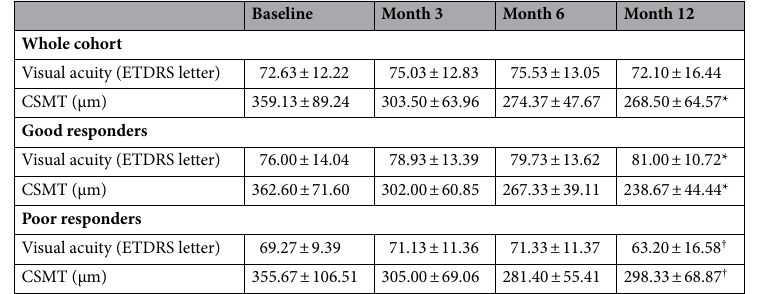
Table 3. Visual acuity and central subfield thickness (CSMT) during the follow-up. *p < 0.01 compared to baseline using repeated measures analysis of variance test. † p < 0.01 compared to good responders using the independent samples student’s